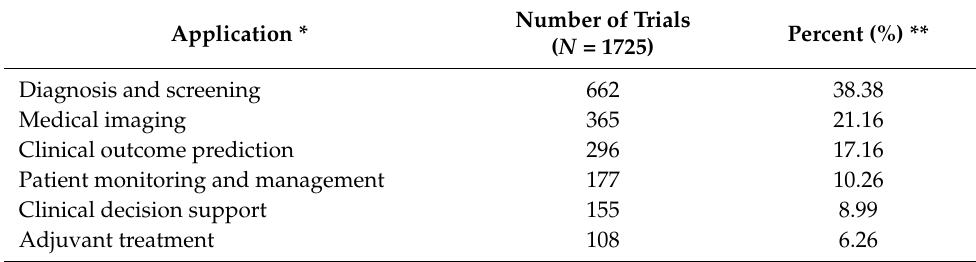
Table 7. Healthcare application fields of AI-related